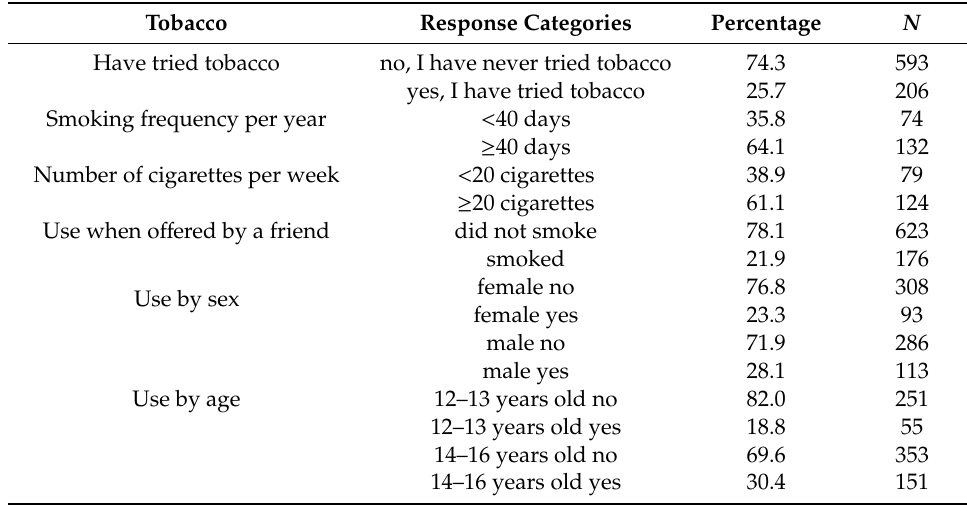
Table 1. Prevalence of Tobacco